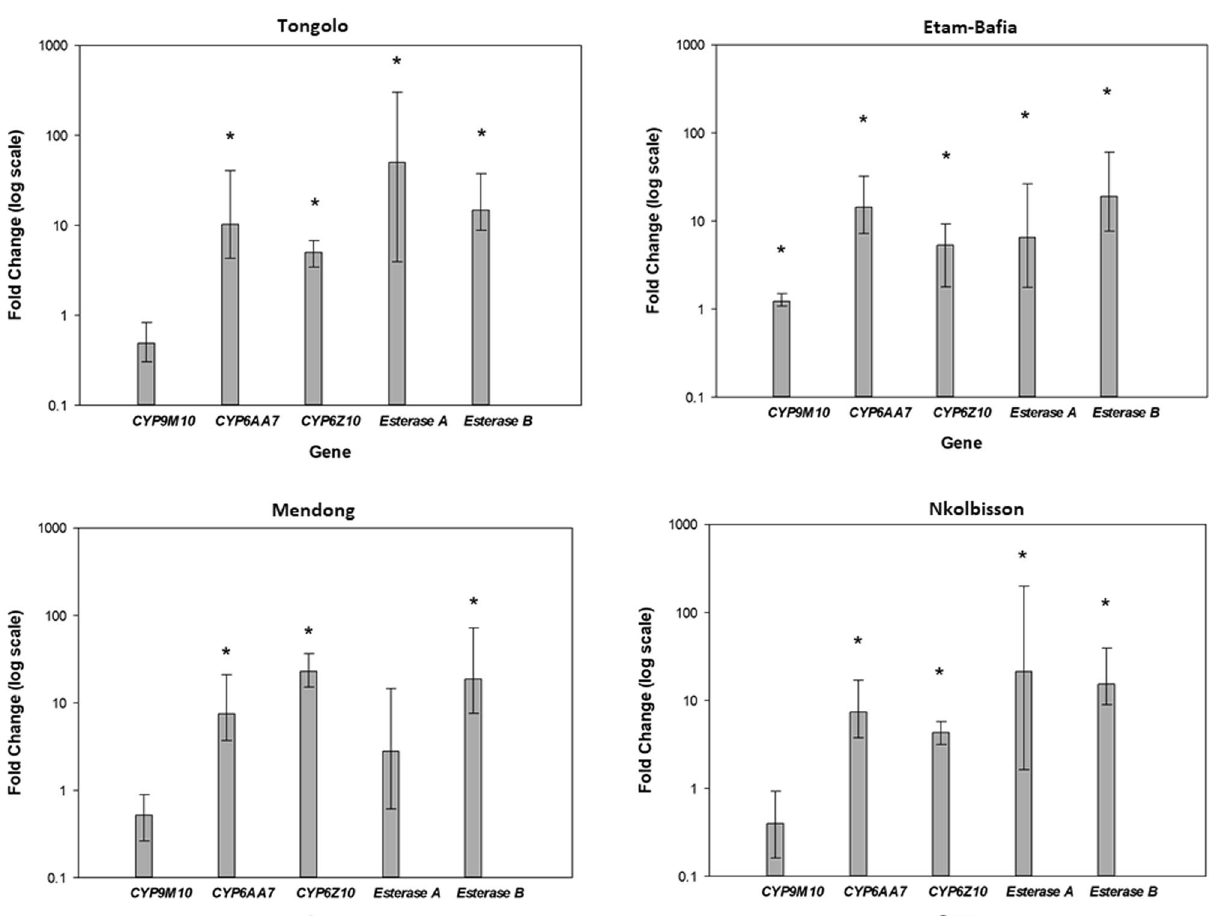
Figure 3. Expression analysis of detoxification genes in the four resistant Culex quinquefasciatus mosquito populations. Error bars indicate 95% CIs. Stars denote statistically significant